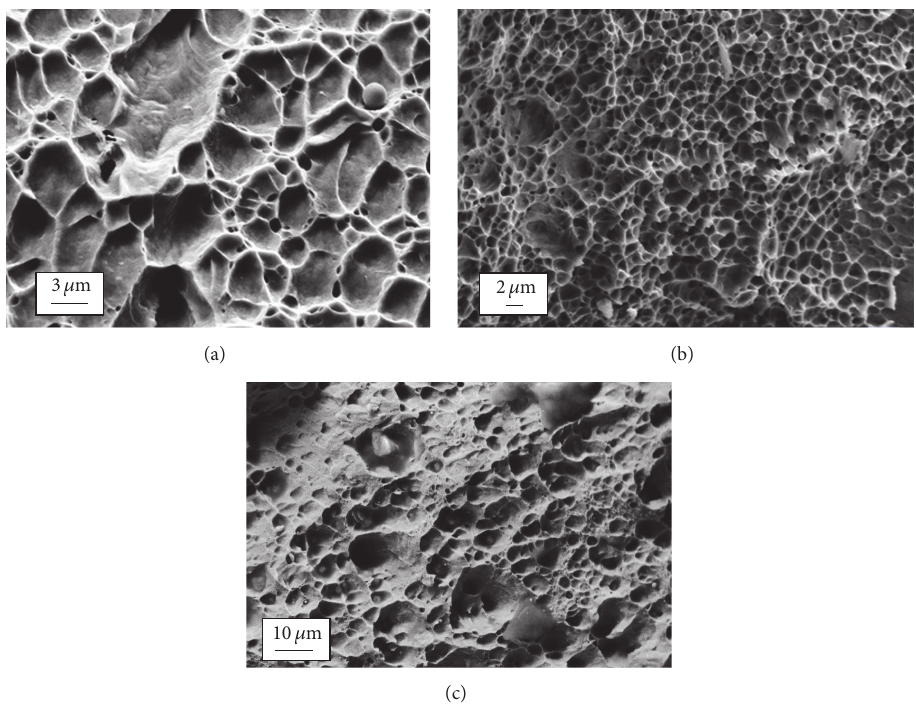
Figure 10: The fractography of welded samples: (a) sample 3; (b) sample 4; (c) sample 5.